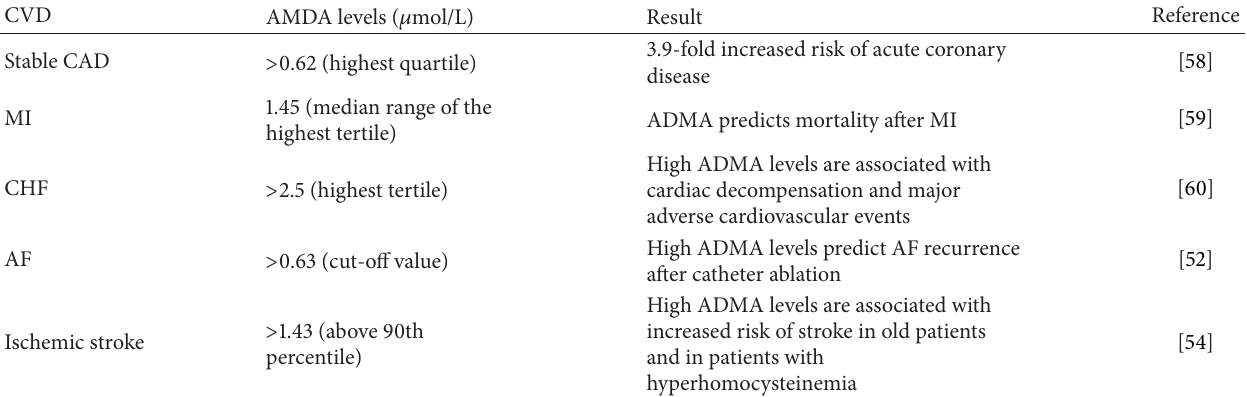
Table 1: ADMA as a cardiovascular risk marker in some cardiovascular clinical